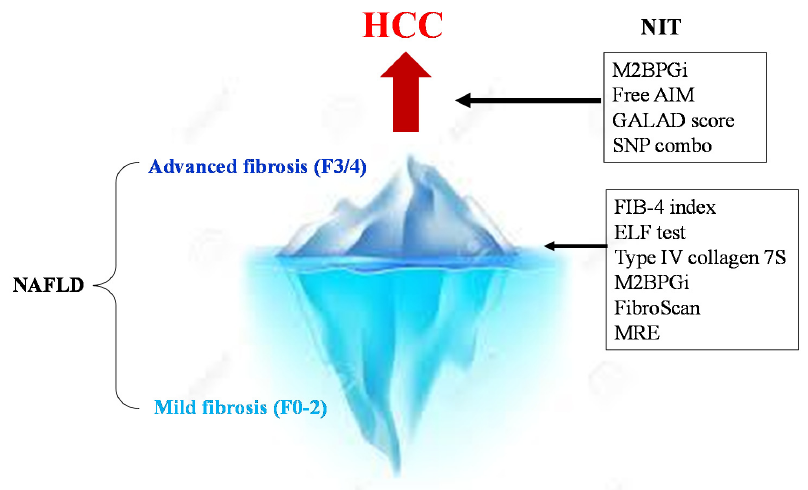
Figure 2. NITs for the surveillance of severe fibrosis and HCC in NAFLD. First, the NIT is used